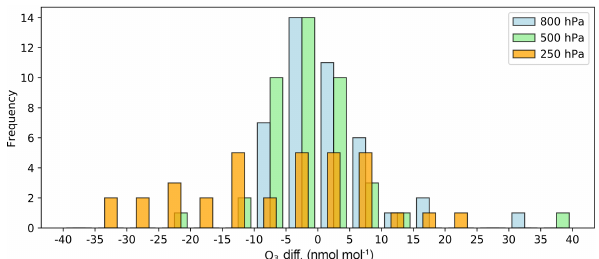
Figure 6. Frequency distributions of the ozone bias (in nmolnmol − 1 ) at the 42 stations from Tilmes et al.